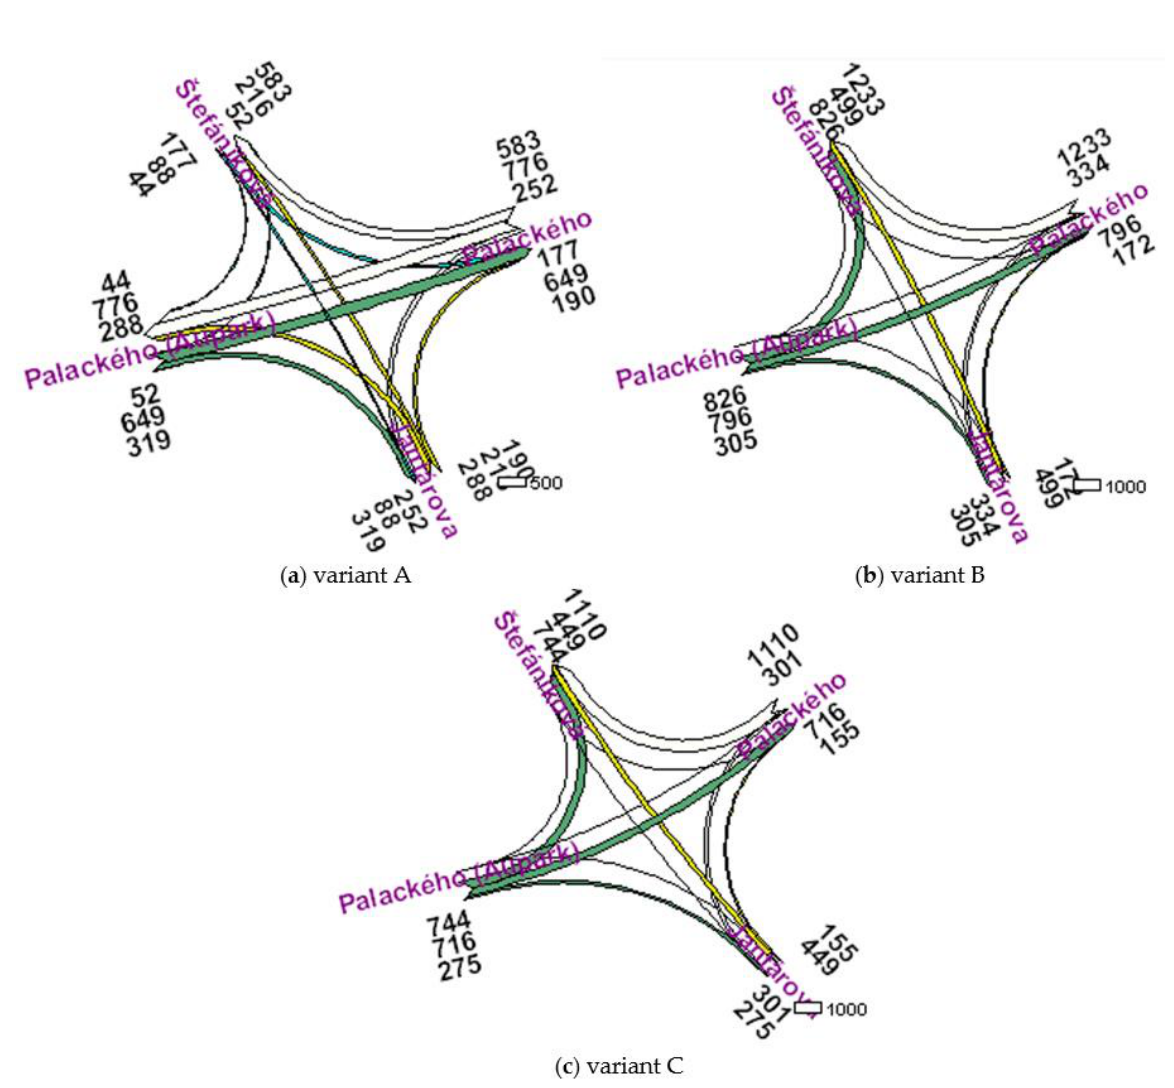
Figure 10. Illustration of traffic flow intensity at a light-controlled junction Palackého – Jantárová (source elaborated by authors).